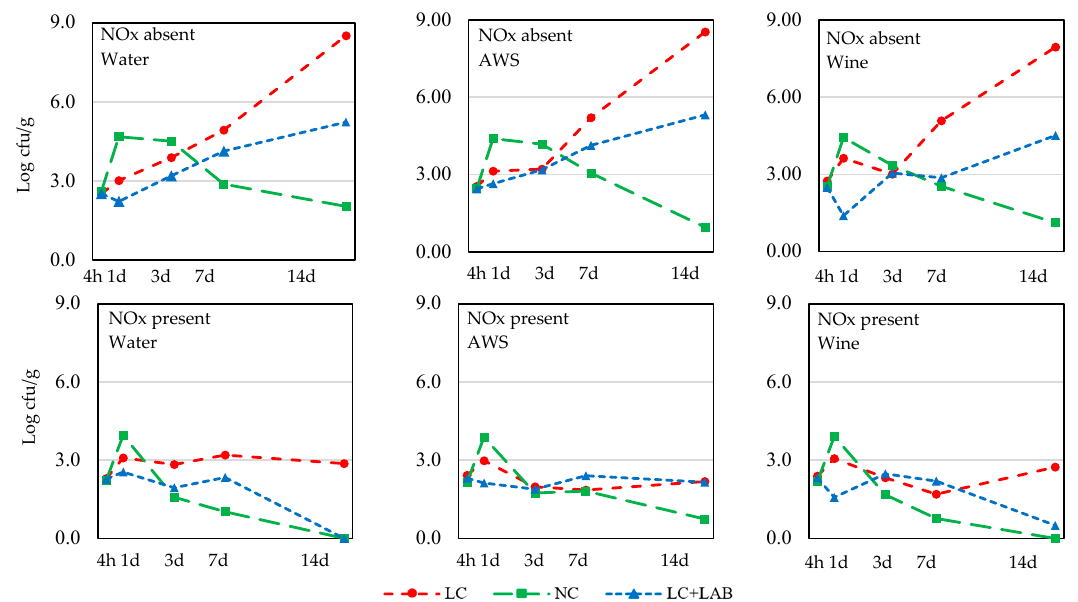
Figure 2. The behavior of Salmonella spp. during the incubation of the chouriço batter made from low contaminated meat ( LC ), normal contaminated meat ( NC ), and low contaminated meat with LAB added ( LC + LAB ), with or without nitrite plus nitrate ( NOx ) and water, artificial wine solution ( AWS ), or wine ( n = 4).